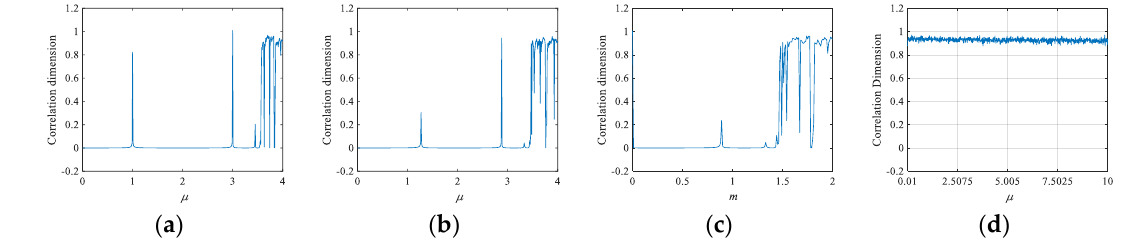
Figure 6. The values of the correlation dimension for different maps. ( a ) Logistic map; ( b ) Sine map; ( c ) Quadratic map; ( d ) The proposed system.